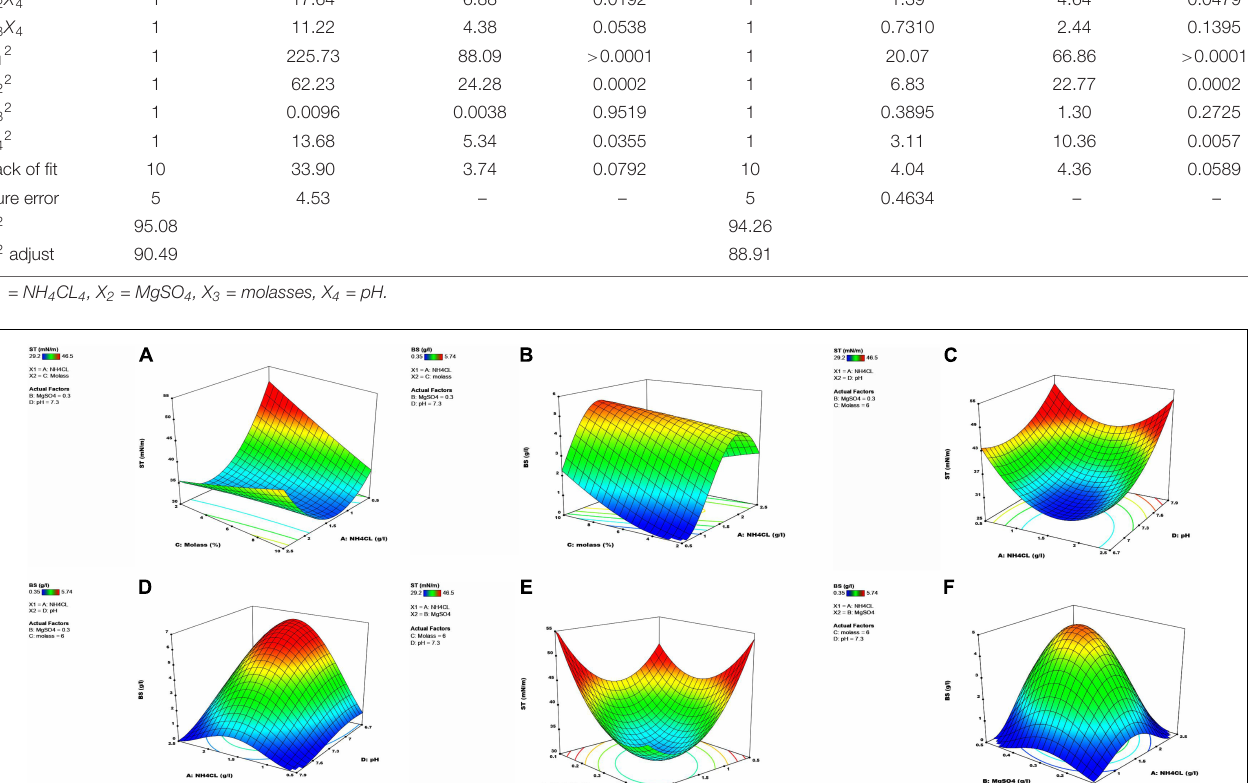
ceases biosurfactant production (Doelle and Doelle, 1990).